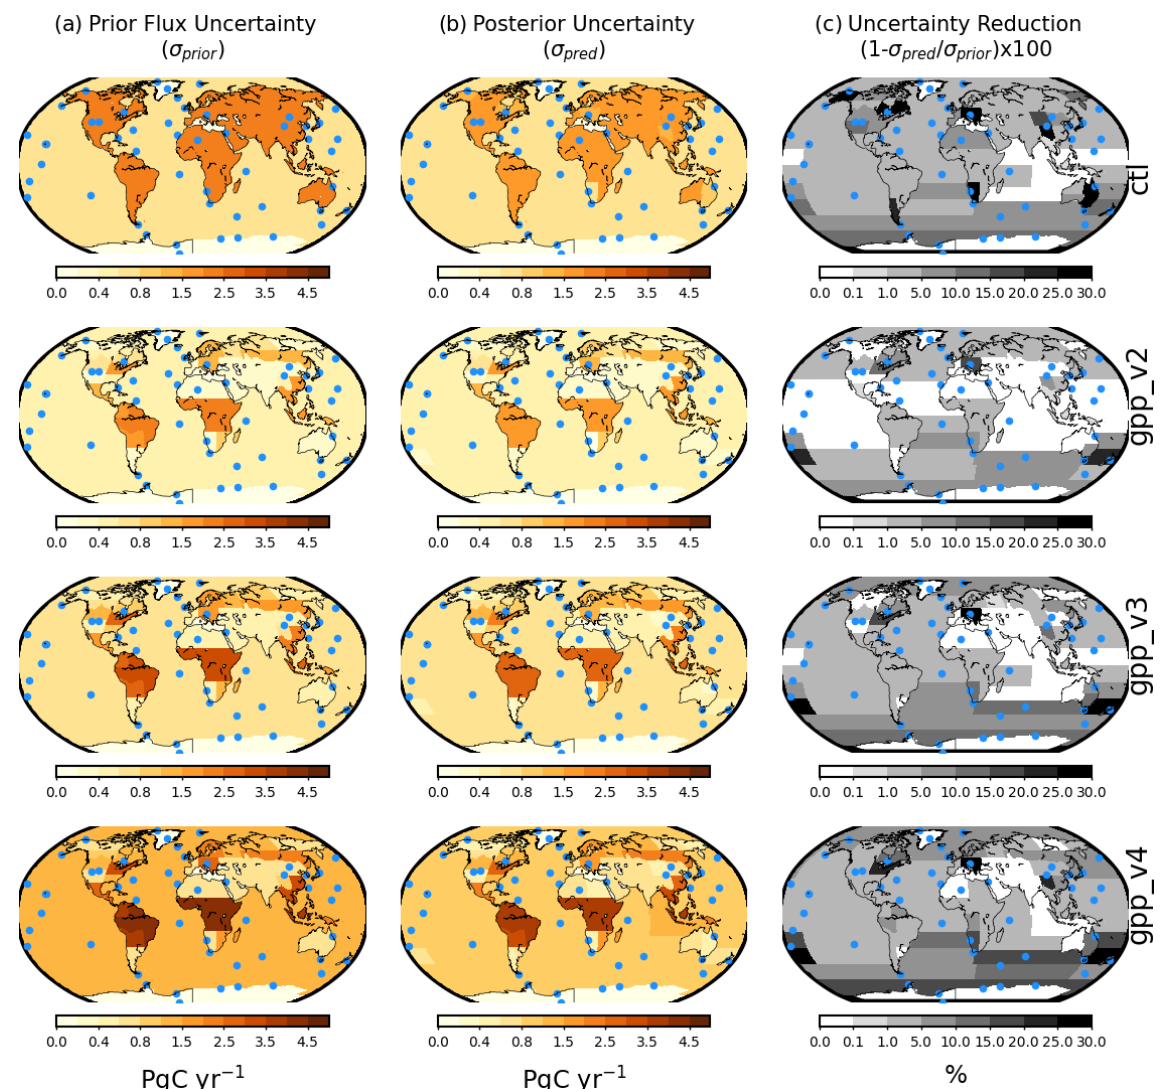
Figure 3. Prior and posterior flux uncertainties for four different PFU (four rows: ctl, “gpp_v2”, “gpp_v3”, gpp_v4) cases are shown in the left and middle column, respectively, and the flux uncertainty reduction (FUR) in the right column. The FUR is an indicator of constraint provided by atmospheric observations. High values (towards 100) in uncertainty reduction indicate strong data constraints, while low values (close to 0) indicate that the data are not able to move the estimates away from the prior flux. All cases correspond to the MDU case ux4 and gc3t inversion case. The circles show the 50 observation sites used for inverse